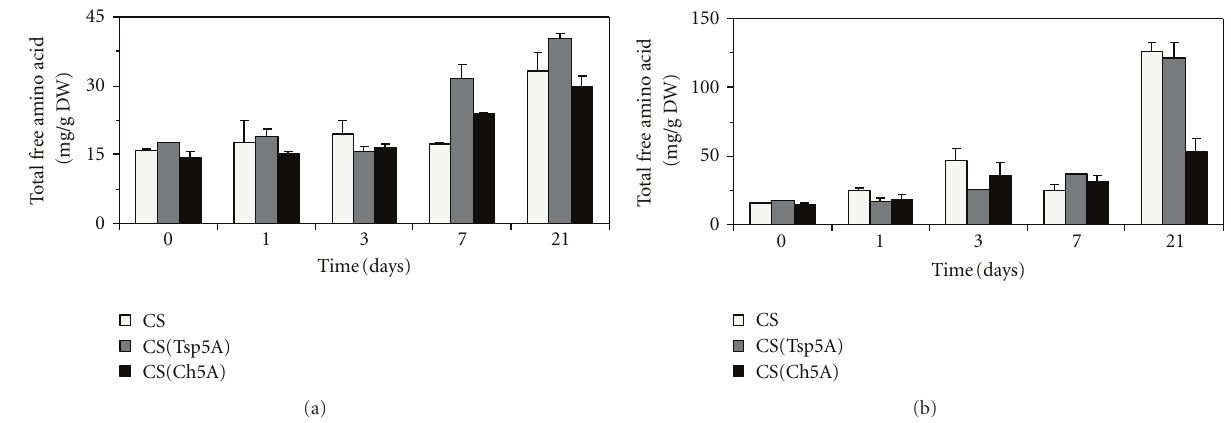
Figure 2: E ff ect of osmotic stress on total free amino acid content. The time course of changes was compared under control ((a); SD: 4.47) and stress (15% PEG; (b); SD: 12.68) conditions in the freezing-sensitive CS and CS(Tsp5A) and the freezing-tolerant CS(Ch5A) wheat genotypes.